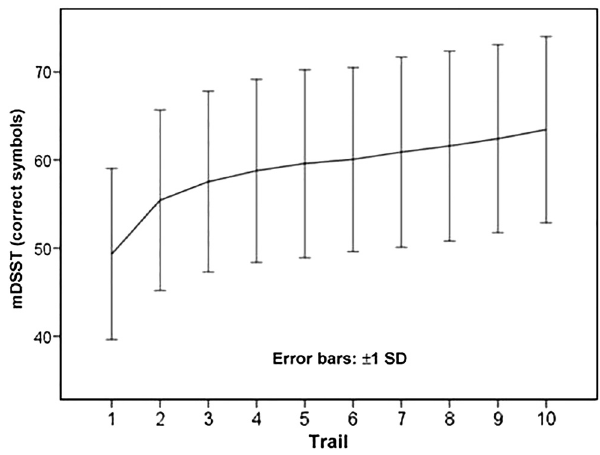
Figure 1. Mean score in the modi fi ed DSST in 10 consecutive trials of the testing-the-limits paradigm for the assessment of CR. Vertical bars indicate ±1 SD.